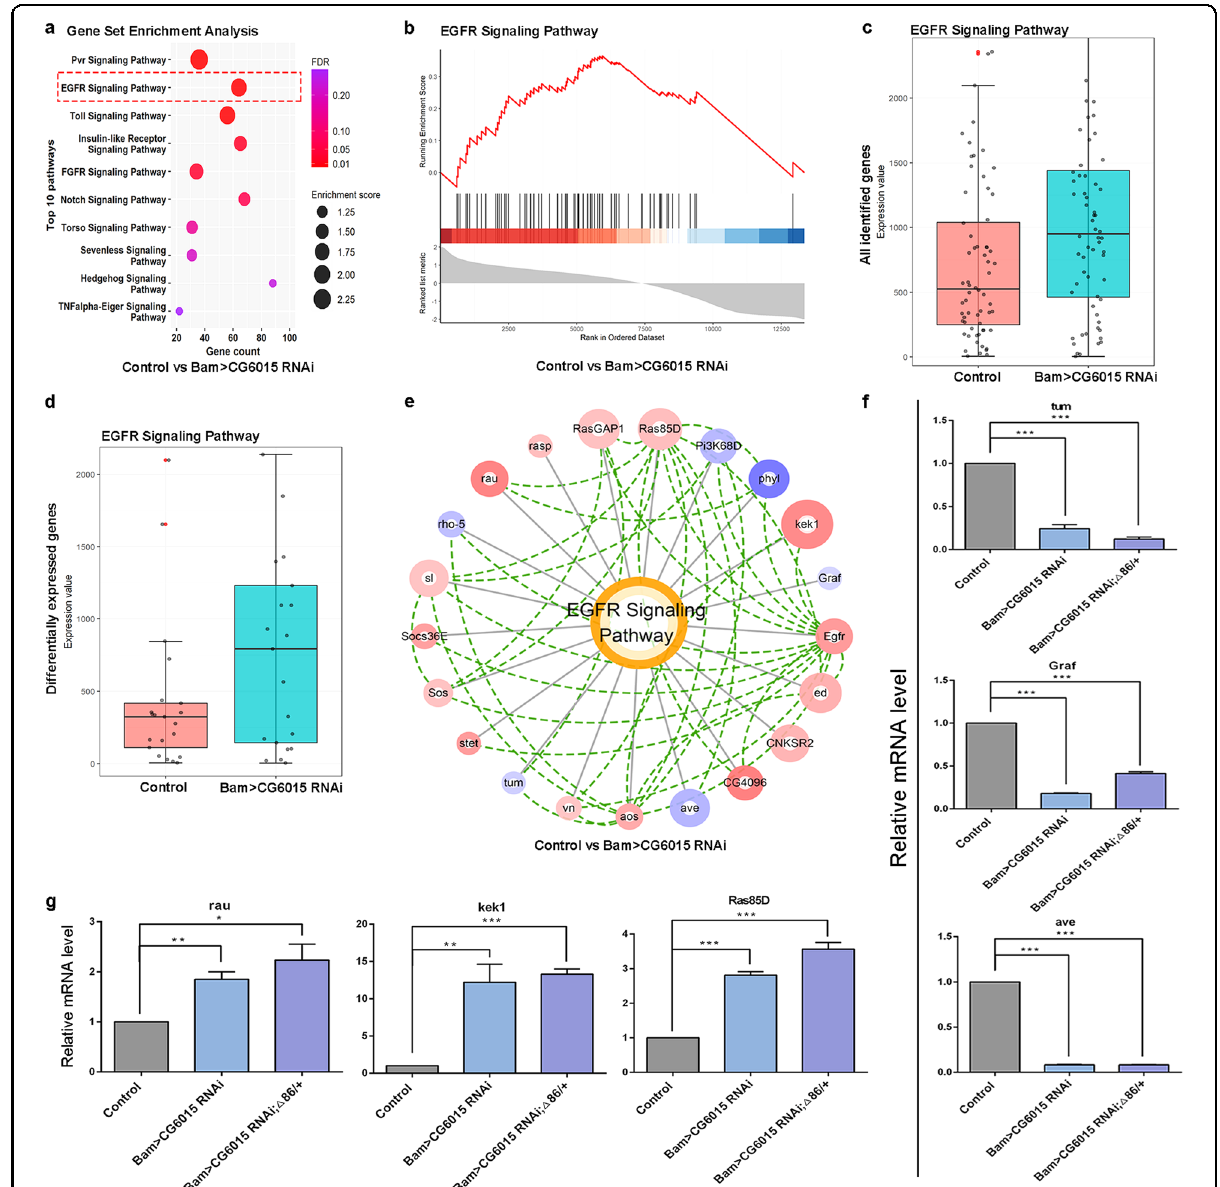
Fig. 5 Inferred signaling pathways and CG6015-mediated regulators during spermatogonia TA-divisions. a Dot plots of the top 10 enriched pathways by GSEA from the comparisons of the control vs. Bam> CG6015 RNAi testes. Color scale and dot size represent FDR value and enrichment score, respectively. b Enrichment plot for the EGFR pathway from the comparisons of the control vs . Bam> CG6015 RNAi testes. Enrichment plot showing the distribution of the enrichment score, leading genes, and ranked list metric. c Box plots of EGFR signaling for all identi fi ed genes from the comparisons of the control vs . Bam> CG6015 RNAi testes. d Box plots of EGFR signaling for differentially expressed genes from the comparisons of the control vs . Bam> CG6015 RNAi testes. e Expression-interaction network of the EGFR signaling pathway from the comparisons of the control vs . Bam> CG6015 RNAi testes. Blue and red scales represented low and high expression, respectively, while the circle size is proportional to the statistical signi fi cance (-logFDR). Green lines represented protein interactions. f Relative mRNA level of representative down-regulated genes in the control, Bam> CG6015 RNAi and Bam> CG6015 RNAi; Δ 86/ + testes. g Relative mRNA levels of representative upregulated genes in the control, Bam> CG6015 RNAi and Bam> CG6015 RNAi; Δ 86/ + testes. * P < 0.05, ** P < 0.01, *** P <